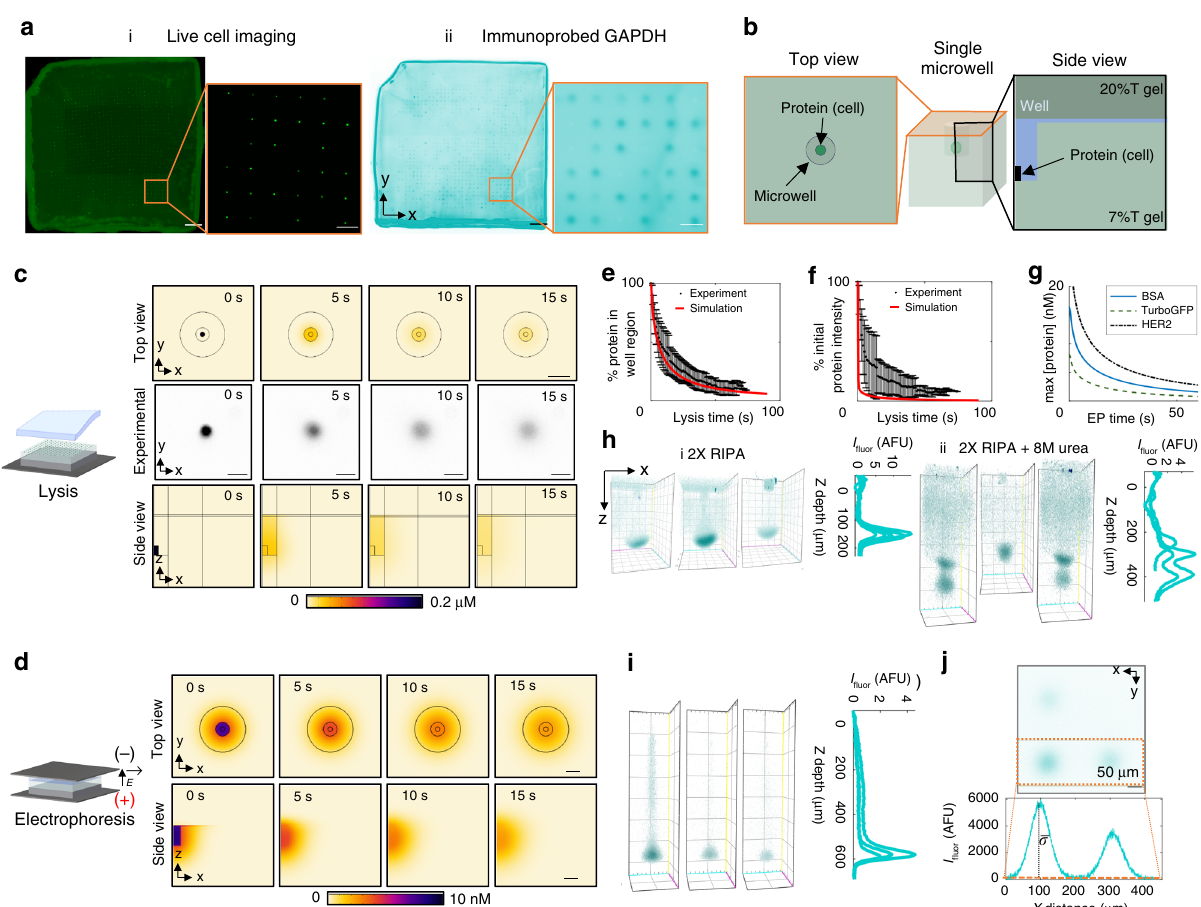
Fig. 4 Design and veri fi cation of sample preparation for projection electrophoresis of single mammalian cells. ( a ) High-density endogenous protein bands (ii) correspond to single-cell settling in microwells (i). Scale bars represent 1 mm (left full-gel images) and 200 μ m (right zoom images). ( b ) Illustration of top-view and side-view geometries shown in protein dilution studies ( c , d ). ( c ) Modeling and experimental quanti fi cation of diffusional dilution during lysis. Simulated and experimental top-view images of diffusional protein dilution during lysis, and side-view simulated results are shown. The simulated initial TurboGFP concentration was 2 μ M. Experimental image is representative of 12 monitored cells across 3 independent lysis experiments. Scale bars represent 50 μ m. ( d ) Modeling the impact of diffusion during electrophoresis on detectable in-gel protein concentration. Side and top view TurboGFP concentration pro fi les are shown at different times during electrophoresis. Simulated initial TurboGFP concentration (before lysis and electrophoresis) was 2 μ M. Scale bars represent 30 μ m. ( e ) Quanti fi cation of the percent of protein remaining in the microwell region during lysis (experiment plots mean and standard deviation of n = 12 cells across 3 lysis experiments). ( f ) Quanti fi cation of the change in the spatial maximum protein concentration as a function of time after protein solubilization (experiment plots mean and standard deviation of n = 12 cells across 3 lysis experiments). ( g ) Simulated maximum protein concentration vs. electrophoresis time, for 3 model proteins. ( h ) Representative β -tubulin separations from U251 glioblastoma cells lysed with different buffer formulations (2× RIPA lysis buffer and 2× RIPA including 8 M urea), both after 10 s electrophoresis. Lysis/EP buffer requires 8 M urea for fast protein solubilization and electromigration. ( i ) Maximum intensity projection 3D renderings and z -intensity pro fi les of probed GAPDH bands from single BT474 breast tumor cells. ( j ) Microwell packing density (impacting assay throughput) is dependent on protein band diffusion before photocapture. Protein diffusion pro fi les con fi rm that a microwell pitch of 200 μ m is suf fi cient to resolve bands from neighboring microwells. After 10 s EP, the mean peak width ( σ xy ) of the xy GAPDH spots is 32 ± 11 μ m (mean ± standard deviation of n = 47 single-cell separation lanes across 5 replicate separation gels). The depicted confocal slice micrograph is representative of 20 confocal image stacks, across different regions of 5 replicate separation gels. At a microwell pitch of 192 μ m (6 σ xy ), <0.3% of the signal should bleed into the neighboring lane. Scale bar represents 50 μ m. Source data are provided as a Source Data fi intensity. Our simulated pro fi les overestimate the diffusional changes during the lysis and electrophoresis stages of the assay, we dilution of protein, predicting only 2.2% of the initial intensity for used a combination of fi nite-element modeling (geometries are in-well lysis after 25 s. We attribute the ~15% discrepancy to shown in Fig. 4b) and experimental monitoring of TurboGFP- delayed solubilization of cellular protein (the models assumed expressing U251 cells during cell lysis (Fig. 4c) and fi nite-element complete solubilization at t = 0), overestimates of the predicted modeling during electrophoresis (Fig. 4d). To compare simulation diffusion coef fi cient used in the simulation, or a possible diffusion and experiment, we integrated the 3D protein concentrations over barrier on the microwell wall surface arising from either the the full z range of the model to mimic detected wide- fi eld presence of Rhinohide ® in the gel matrix or the presence of residual fl uorescence intensities (Fig. 4e, f). Using this metric, after a typical GelSlick ® or dichlorodimethylsilane used during gel fabrication. 25 s lysis time, we measure 17% ± 11% of the initial protein One important consideration for projection electrophoresis is